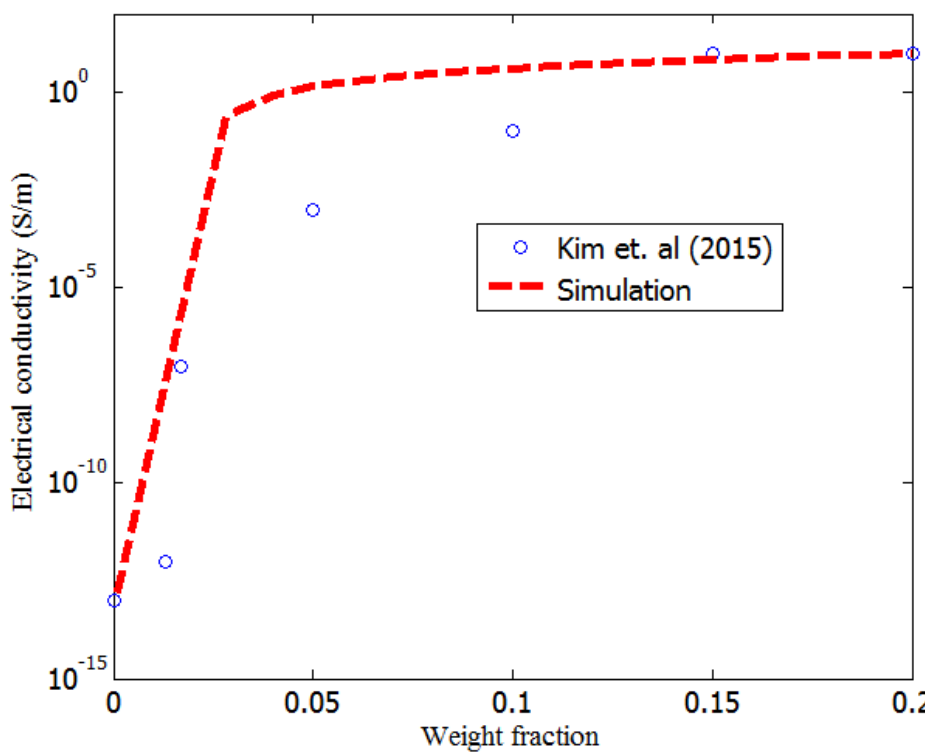
Figure 10. Comparison of the simulation results to measurement results (Kim et al.) [37].